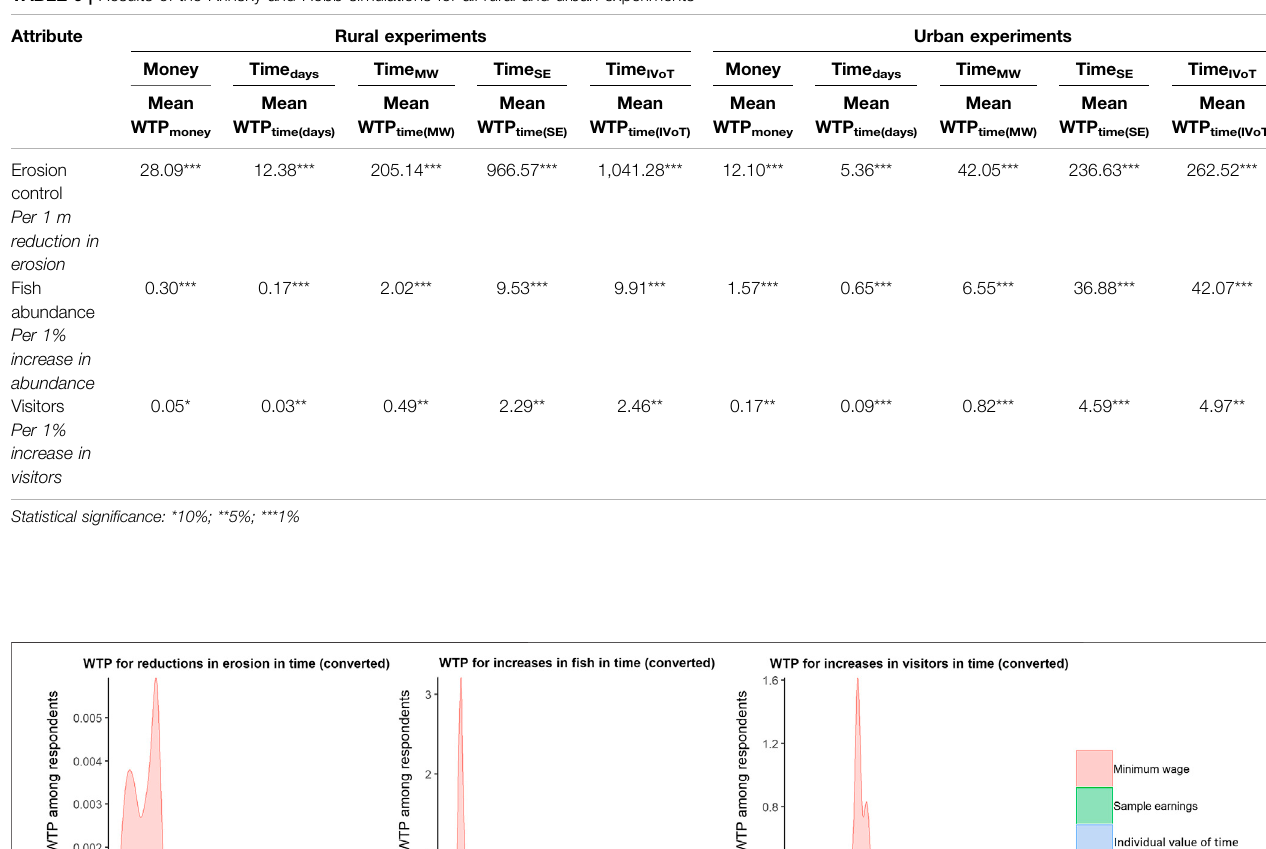
TABLE 6 | Results of the Krinsky and Robb simulations for all rural and urban experiments